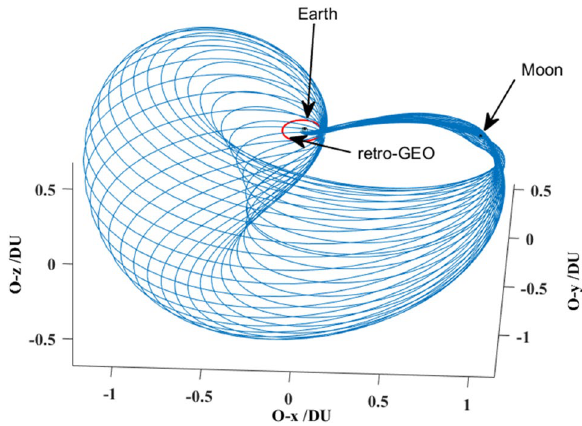
Figure 16. All the spatial paths of the case that (cid:31) t = 4.00 TU.